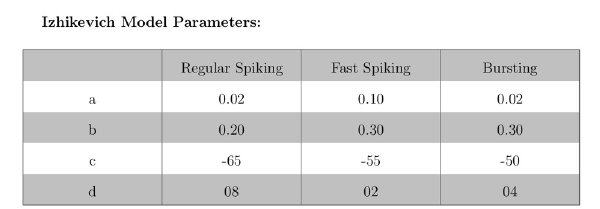
to subscribers until all plugins (in that stage) have updated up to that